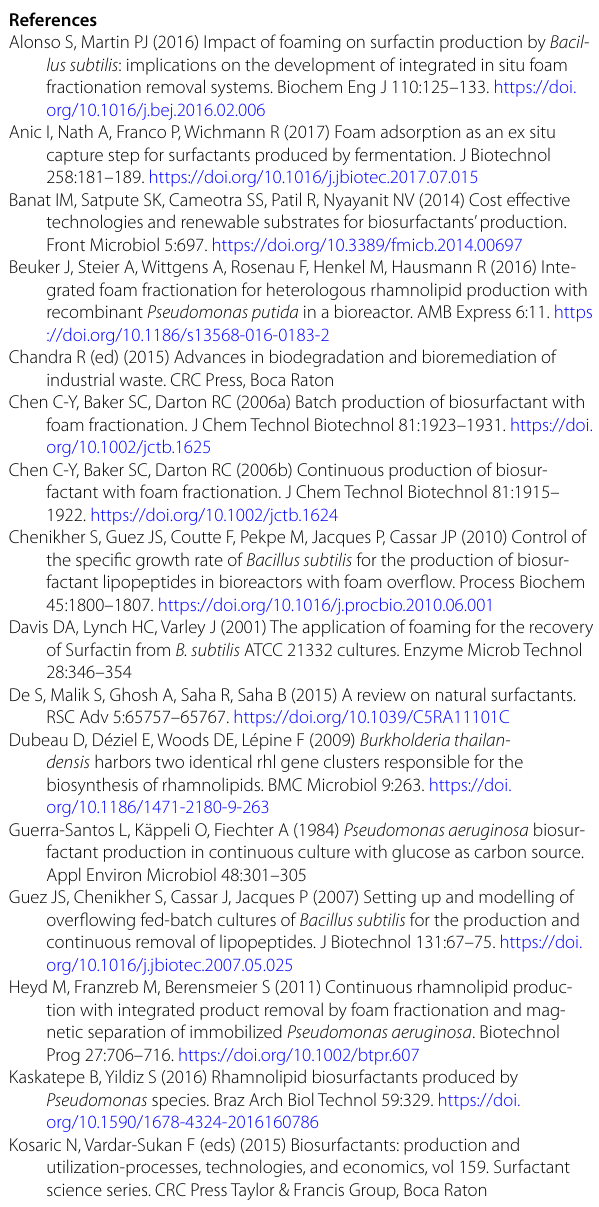
Additional file 1: Figure S1. Feeding rate applied during the fed-batch fermentation process is presented. Feeding pulse was performed